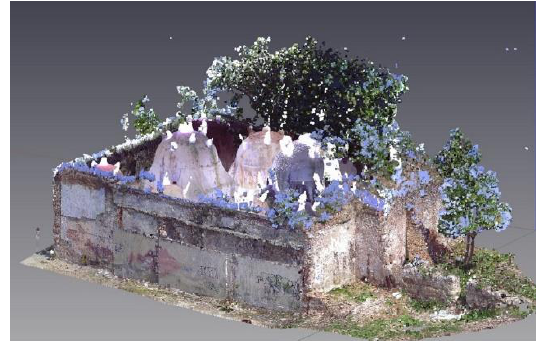
Figure 3. The whole point cloud of the Gazi Evrenos Baths, Giannitsa,